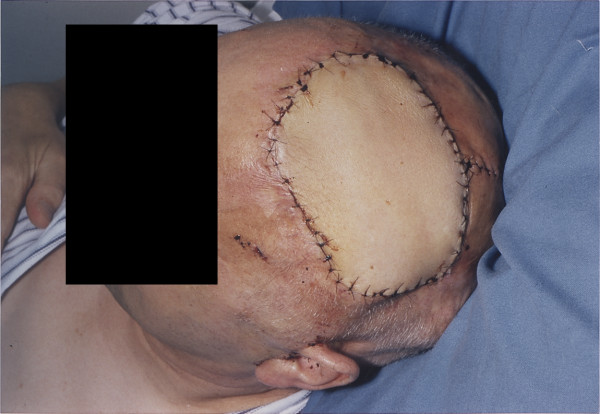
Uncomplicated healing of radial forearm flap on left hemicranium.